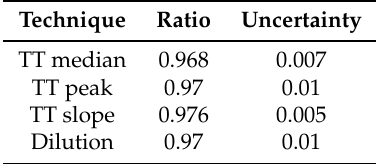
Table 1. Table of the proportionality coefficients between optical techniques and Pitot tube for different analysis procedures.